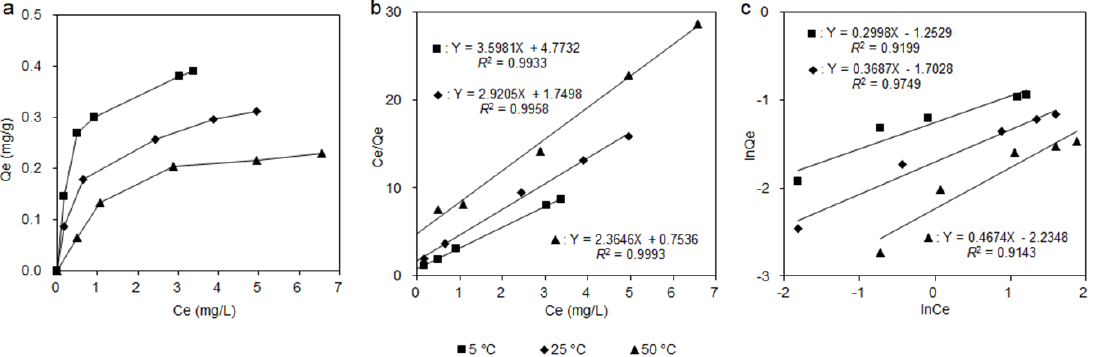
Figure 4. The adsorption isotherms of aucubin ( a ), the fitting result by Langmuir equation ( b ) and Frendlich equation ( c ) on HPD750 at different temperatures.